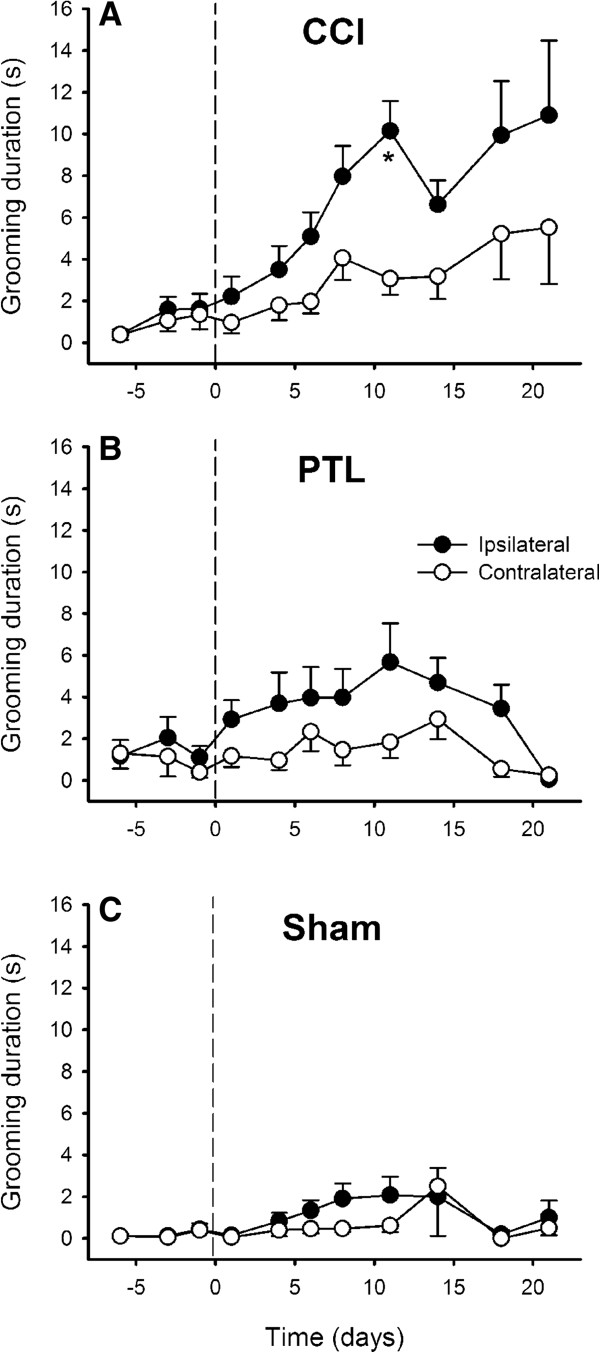
Time course of the development of cold-evoked behaviours after mental nerve injury. Bilateral grooming evoked by cold stimulation (topical ethyl chloride) of the chin was significantly increased 11 days after chronic constriction injury (CCI) of a mental nerve (A), but not after partial tight ligation of the nerve (PTL; B) or sham operation (C). The operation was performed on day 0 (indicated by the dashed line). Symbols are mean ± 1 S.E.M. Asterisk indicates significant differences between ipsilateral and contralateral sides (P < 0.002; 2-factor repeated measures ANOVA followed by Tukey’s test post-hoc). CCI, n = 22; PTL, n = 19; Sham, n = 17.